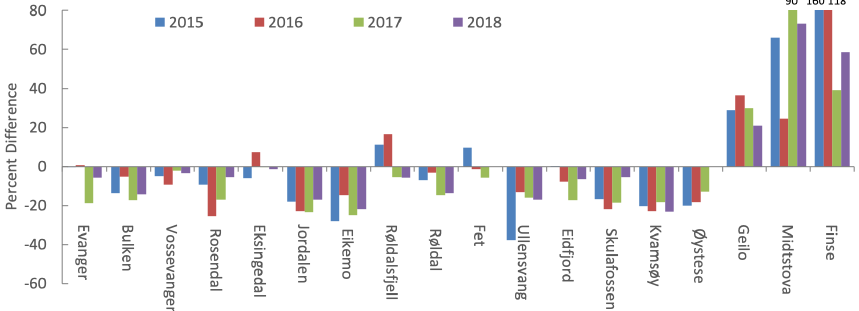
Figure 4. Percent difference in simulated and observed precipitation at all stations for mass balance years 2015–2018. Some values above Midtstova and Finse are above the axis limit and are therefore indicated with